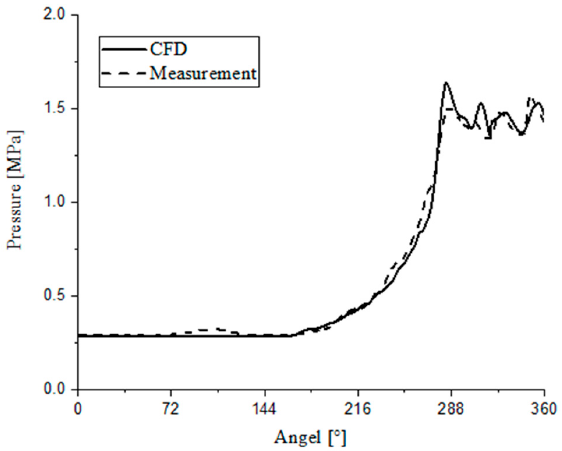
Figure 13. The P- θ diagram of the screw refrigeration compressor under partial load (75%) conditions.